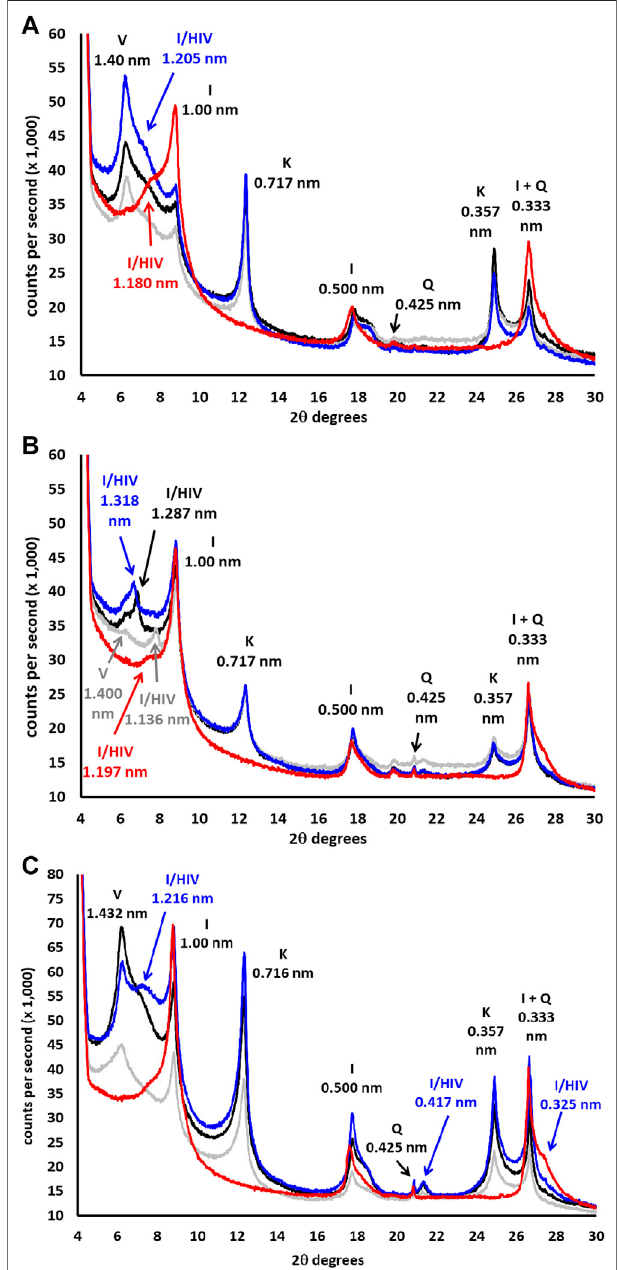
FIGURE 2 | DRX mineralogical composition of the clay fraction ( < 2 μ m; DRX- oriented aggregate) in the 4 – 30 ° 2 θ . (A) forest sample, (B) organic sample, (C) conventionalsample.Blackline=Mgair-dried,grayline=Mg-EG, blue line = K air-dried, red line = K 520 ° C. V: vermiculite, HIV: hydroxyl- interlayered vermiculite, I: Illite, K: kaolinite, Q: quartz.